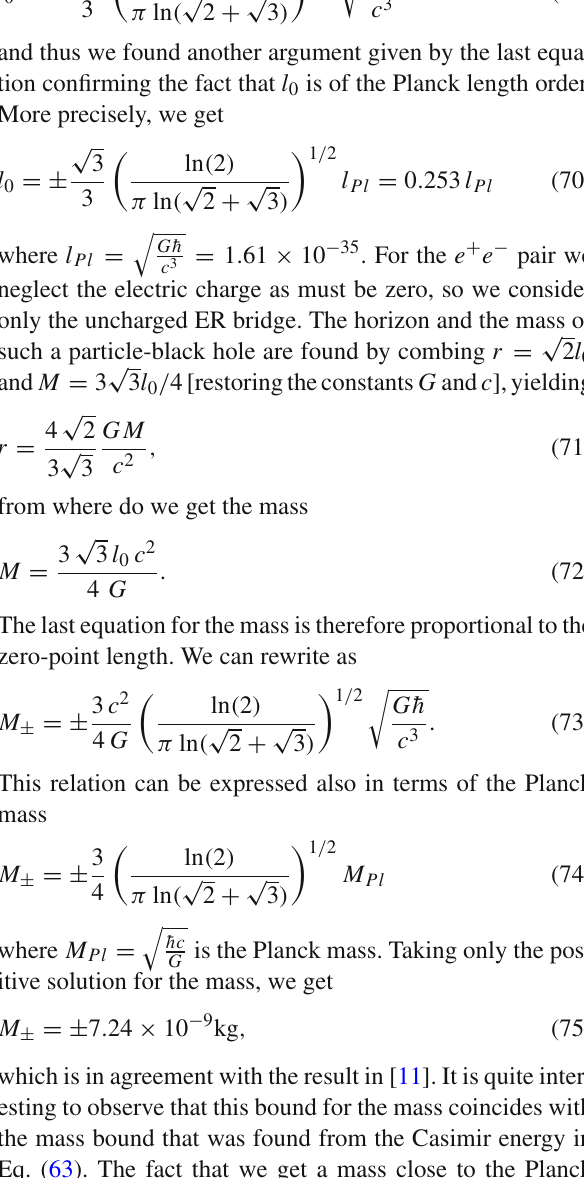
Fig. 2 Schematic plot from [11] of entangled e + e − pair and the ER bridge connecting the